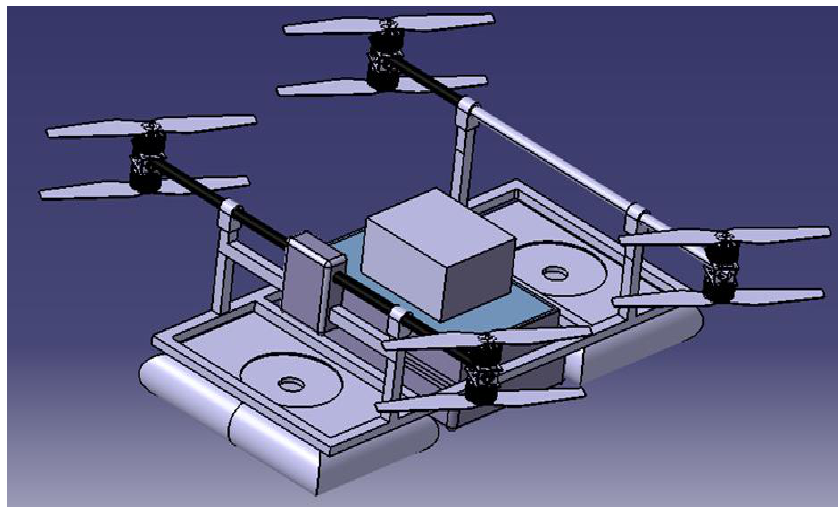
Figure 1. Conceptualized model of amphibious